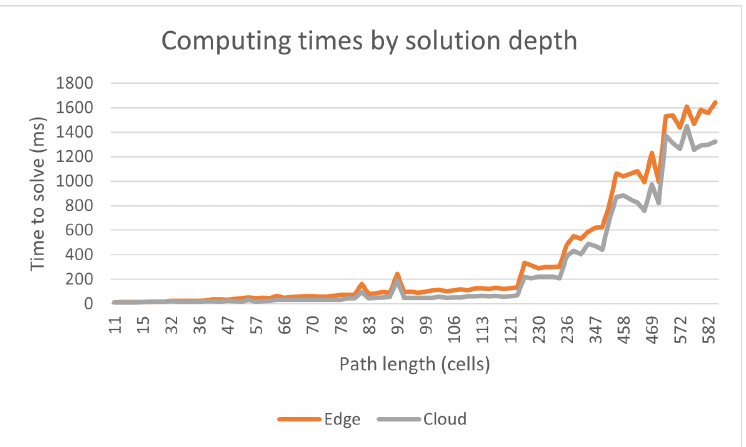
Figure 1. Time required by the algorithm to find a path plan in both edge and cloud environments.